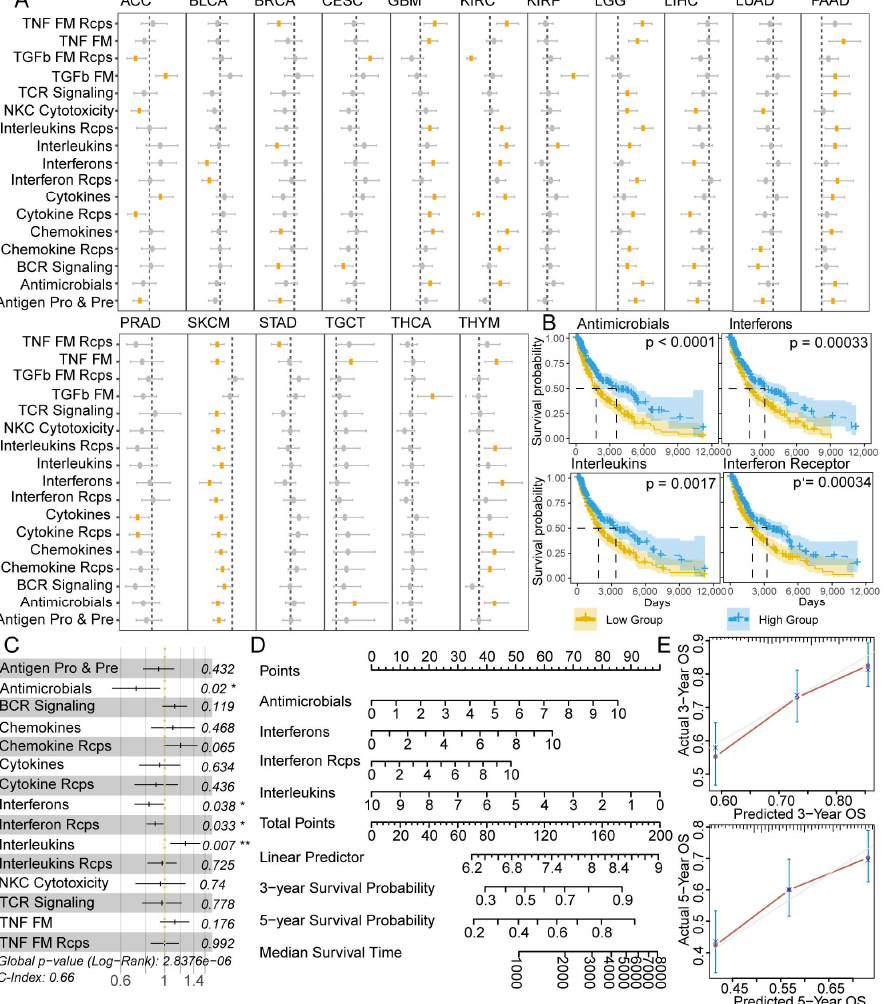
Figure 5. Clinical relevance of 17 IRPs among 25 cancer types. ( A ) Forest plot showing the results of Univariate Cox regression in pan-cancer. Rectangle dots represent hazard ratio (HR) and the error bars show the 95% confidence intervals of the HR. Orange denotes statistically significant. ( B ) KM curves for SKCM patients stratified by median level of 4 IRPs. ( C ) Forest plot showing the results of multivariate Cox regression in SKCM patients. ‘*’ denotes p < 0.05, ‘**’ denotes p < 0.01. ( D ) Nomogram using 4 IRPs for predicting the probability of 3- and 5-years OS. ( E ) Calibration plot evaluating of the predicted results by nomogram. The red and gray lines represent the difference between predicted and observed